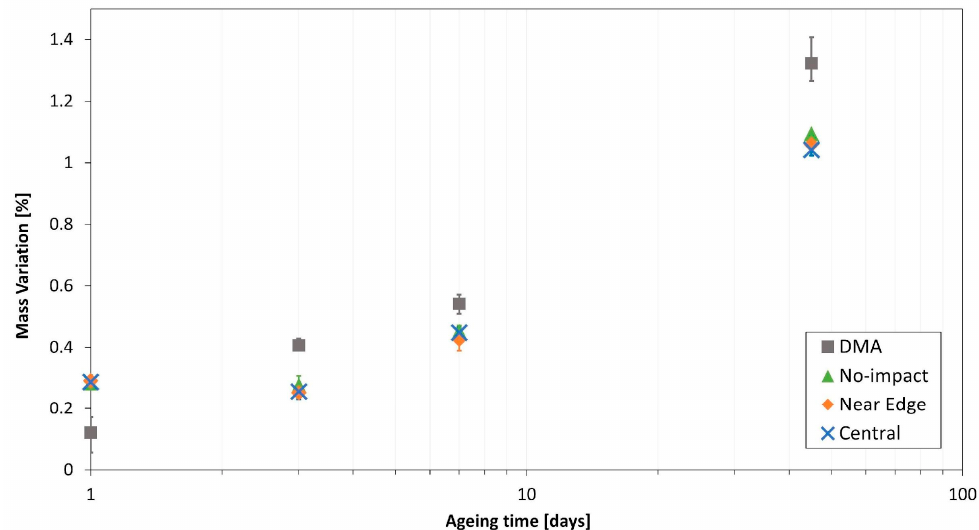
Figure 4. Mass variations mean values comparison—all coupons. A logarithmic scale was used for the horizontal axis.